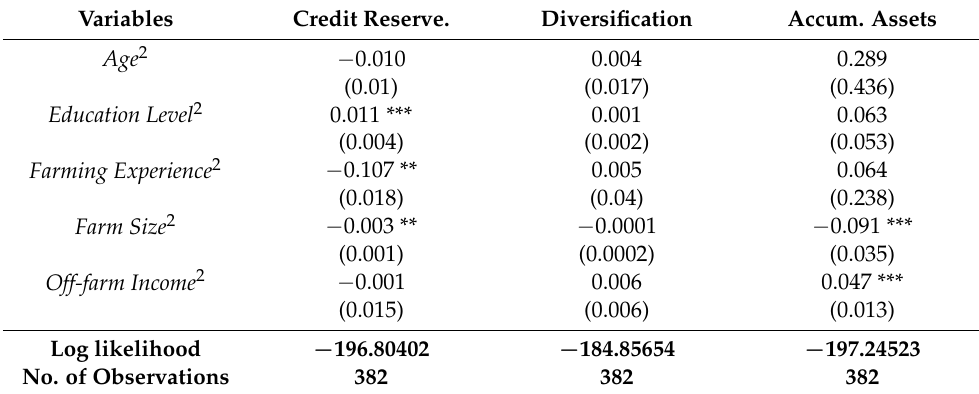
Table 14. The non-linear effect of the covariates on the adoption of RMS. Variables Credit Reserve.